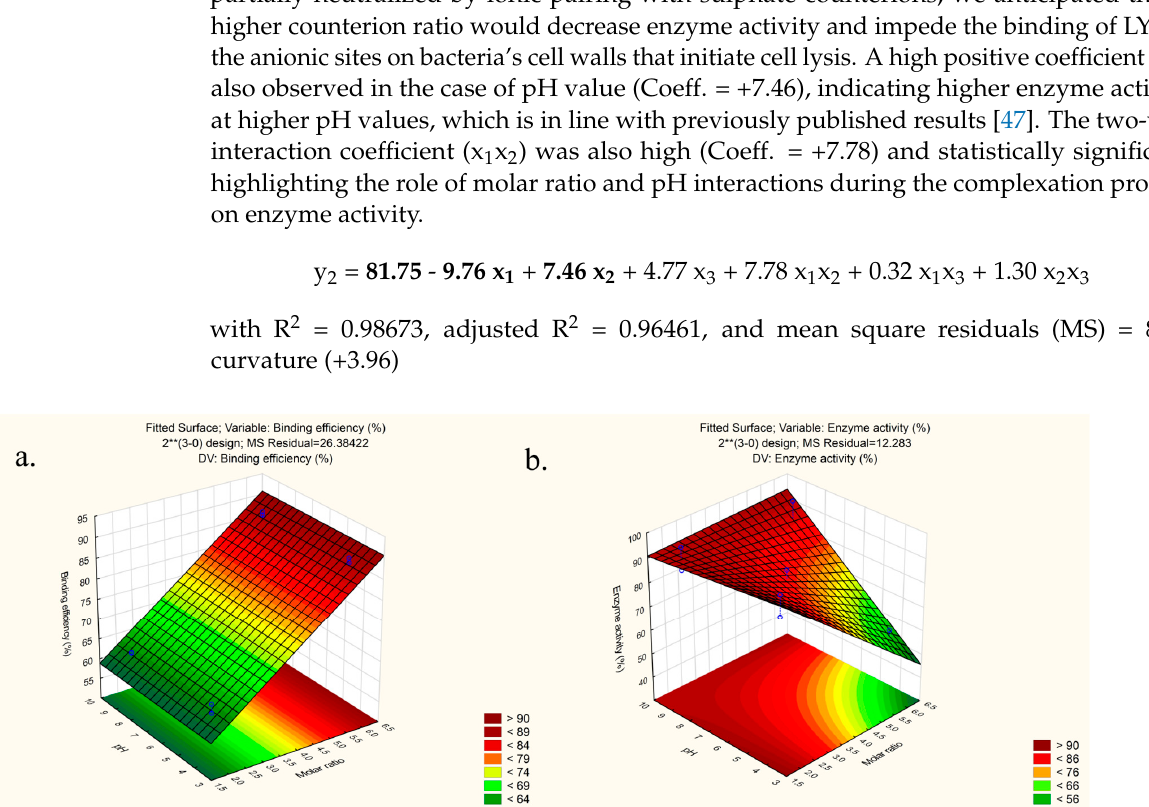
Table 5. The experimental and predicted values of the responses of the optimized complex LYS:SDS. Data are presented as mean ± SD ( n = 3).